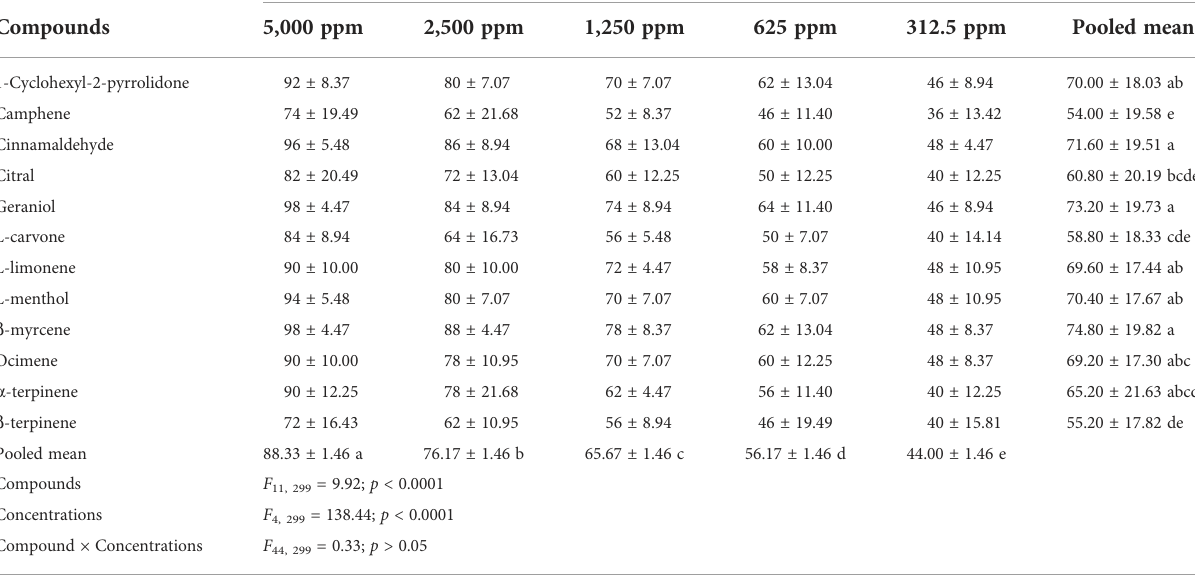
Compound × Concentrations F 44, 299 = 0.33; p > 0.05 Mean of fi ve replications: Means followed by the same letters within a column are not statistically signi fi cant (p > 0.05) by Tukey ’ s